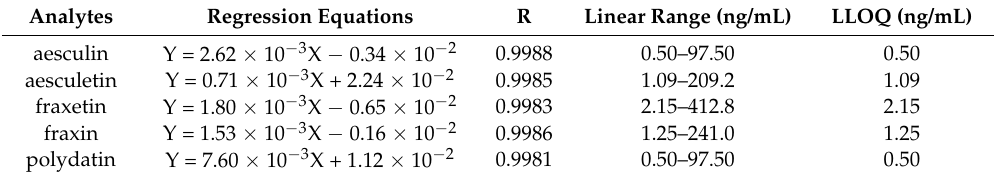
Table 2. Regression equations, correlation coefficients and linear ranges of analytes in beagle dog plasma. Analytes